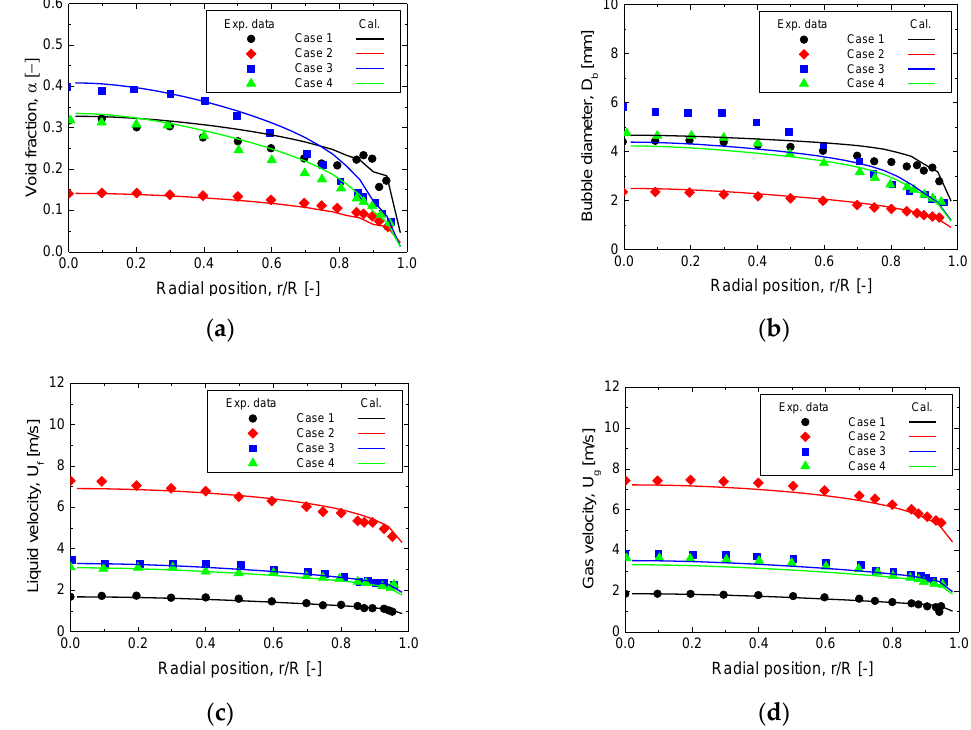
Figure 6. Comparison of the predicted two-phase parameters with the Hibiki experiment: ( a ) void fraction, ( b ) bubble diameter, ( c ) liquid velocity, and ( d ) gas velocity.